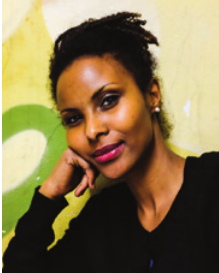
Figure 2 Sada Mire (Source: photograph by Daniel